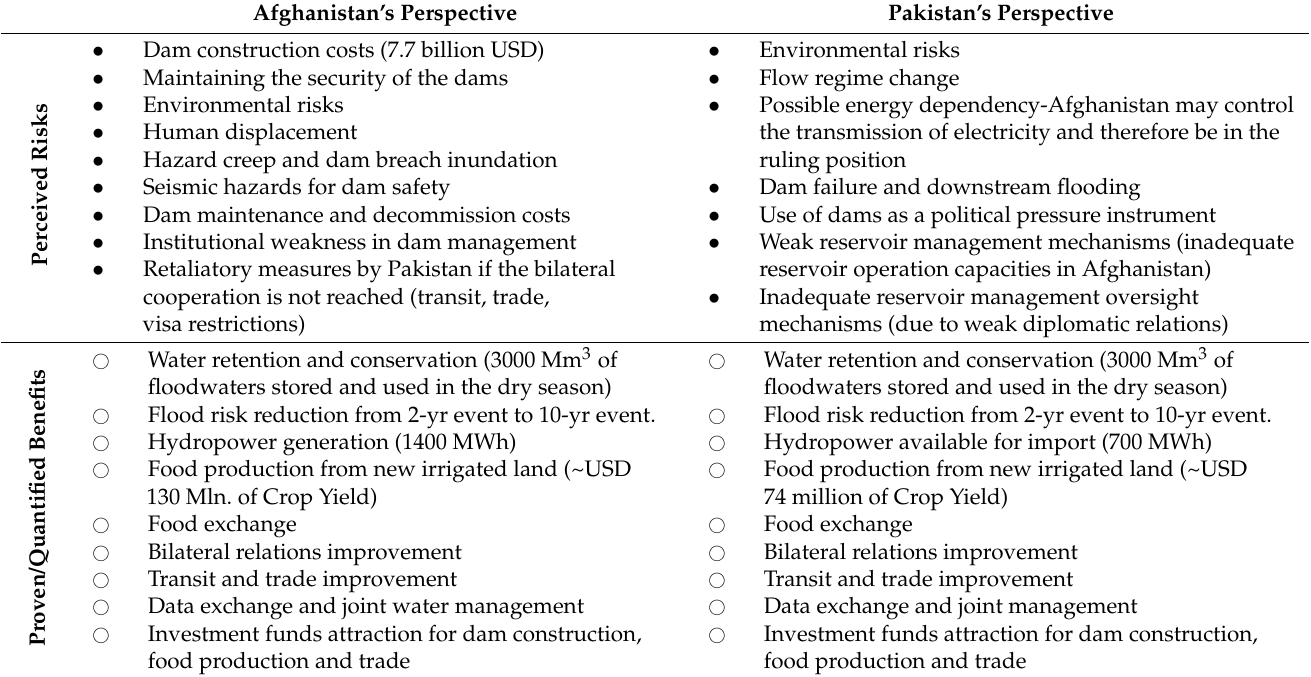
Table 8. KRB Risk/Benefit Chart for Afghanistan and